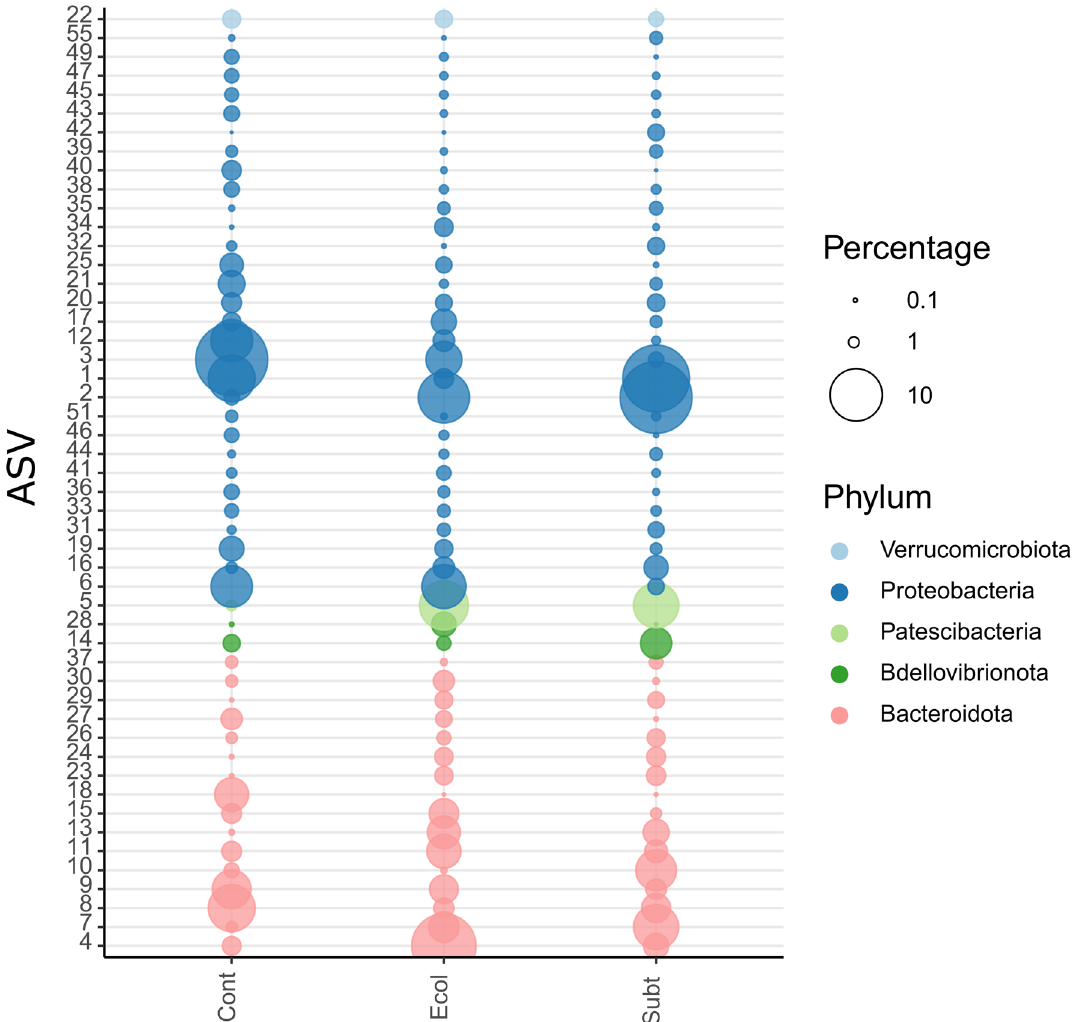
Figure 6. Relative abundances of the 50 most abundant ASVs colour-coded according to prokaryotic phylum for: Cont: Control; Ecol: E. coli DH5α; Subt: P. rubra SubTr2. The circle size of the ASV is proportional to the mean percentage of sequences per treatment as indicated by the symbol